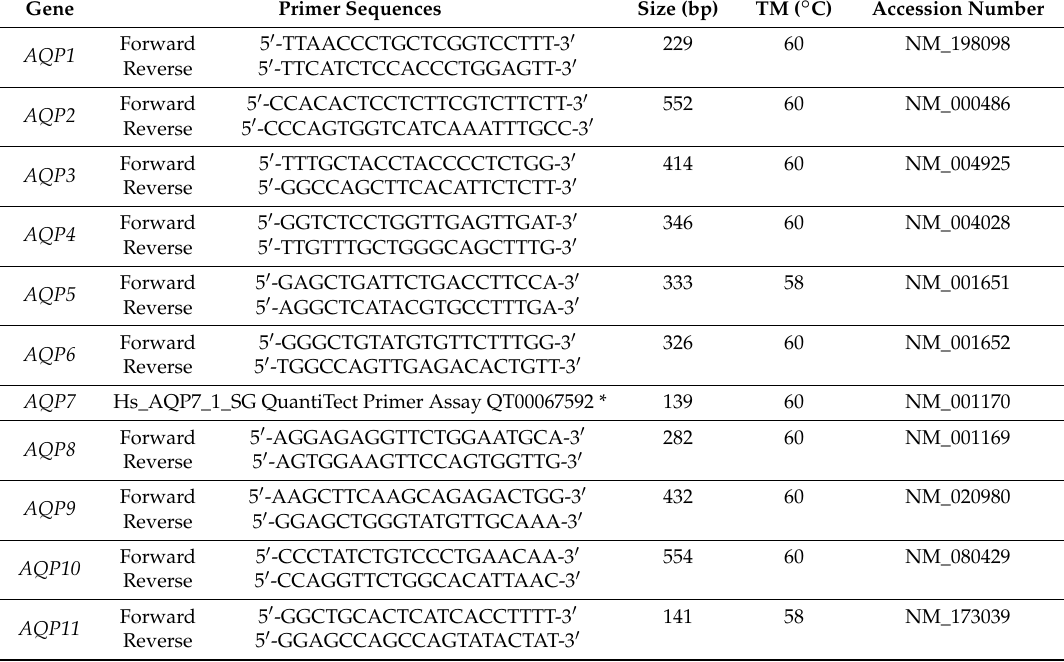
Table 2. Primer sequences used for real time reverse transcription/polymerase chain